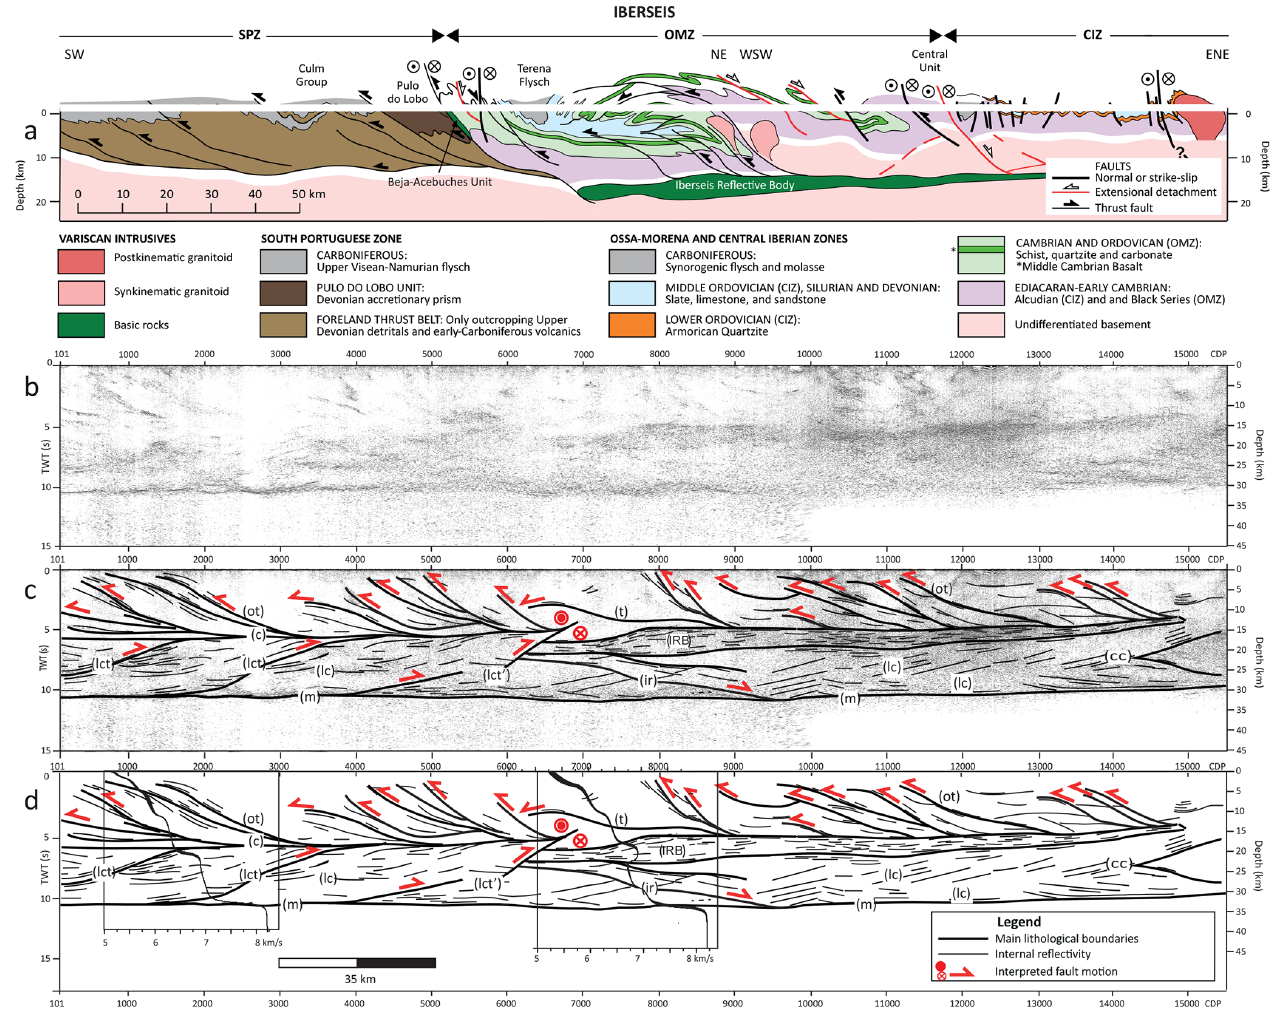
Figure 8. Cross section (a) modified from Simancas et al. (2003) and depth-converted time-migrated section ( v = 6000m/s) of the NI seismic profile IBERSEIS (Fig. 1), without (b) and with (c) interpretation. A sketch of the most important features is presented in panel (d) . Two 1D velocity profiles as modeled from wide-angle data (Palomeras et al., 2009) are overlapped in panel (d) .The abbreviations used in the figure are as follows: CDP is the common depth point, TWT is the two-way travel time, CIZ is the Central Iberian Zone, OMZ is the Ossa-Morena Zone, and SPZ is the South Portuguese Zone. The nomenclature for reflections is as follows: (t) denotes thrusts, (ot) denotes outcropping thrusts, (IRB) is the IBERSEIS reflective body, (c) is the top of the lower crust, (lc) is the lower crust, (ir) is the lower crust internal reflectivity, (lct) denotes lower-crust thrusts, and (m) is the Moho. Depth conversion is based on migration